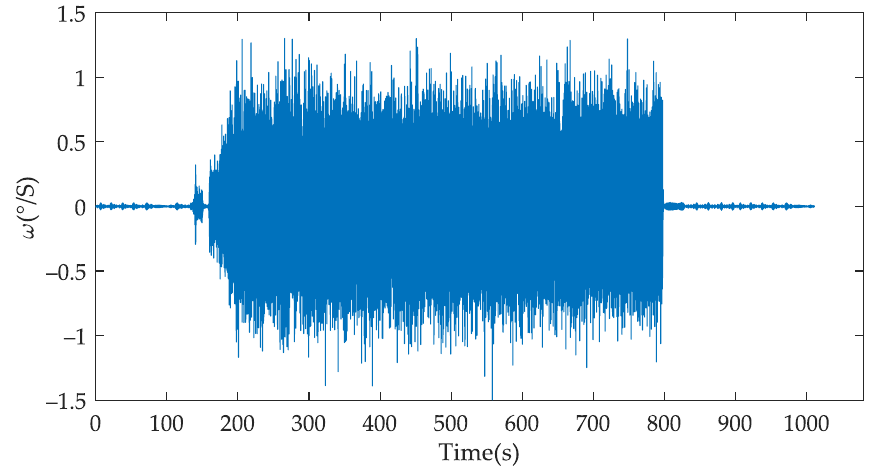
Figure 10. The output of FOG with the random vibration condition.